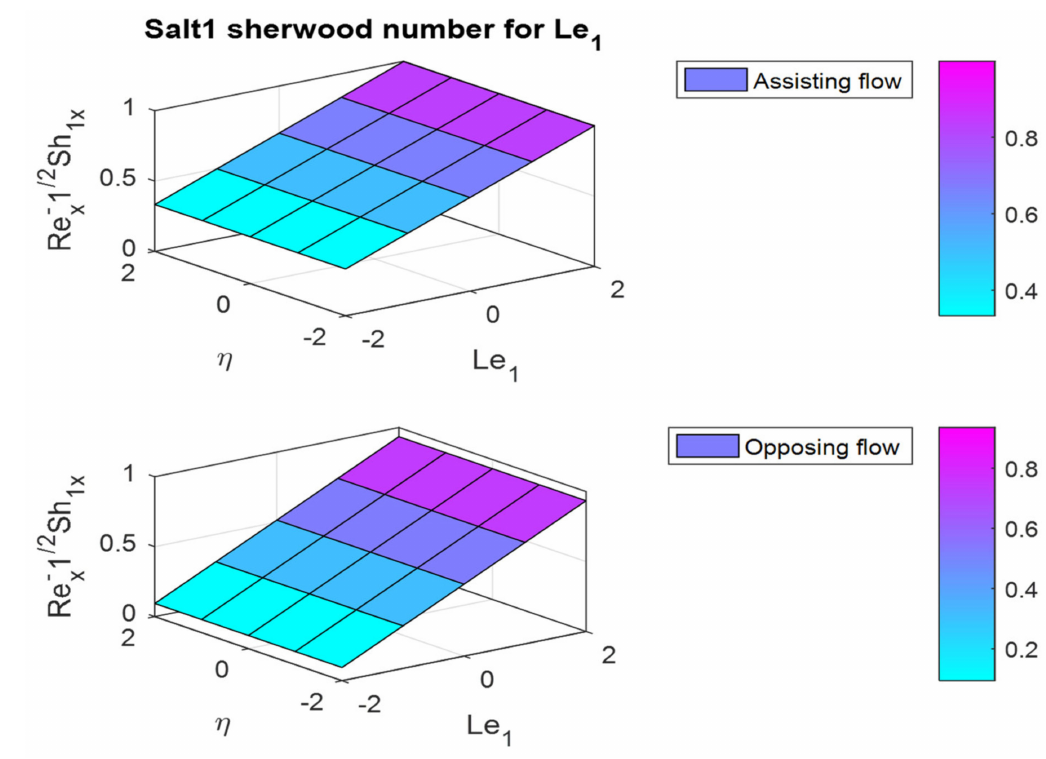
Figure 39. Surface plots for the φ 1 (cid:48) ( 0 ) for dissimilar values of Le 1